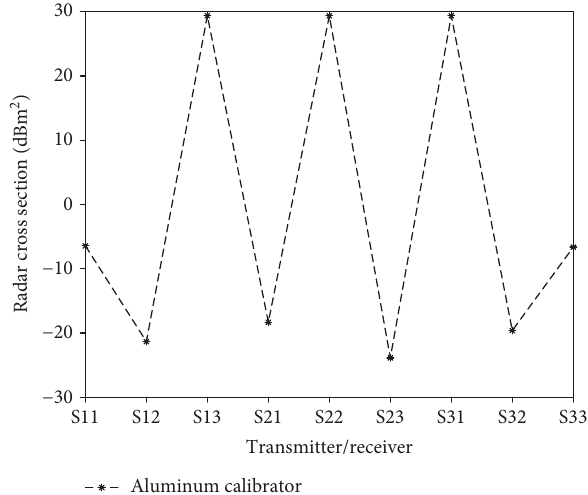
Figure 15: Simulated bistatic RCS values of the 50 ∗ 50 aluminum calibrator.